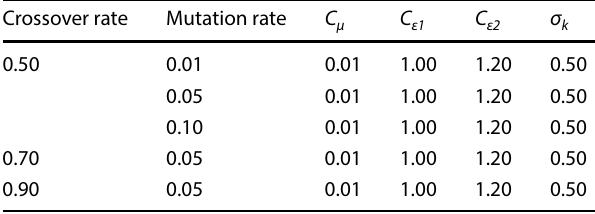
Table 5 Mean calibration values obtained from GA-based simu- lations for different crossover and mutation rates and p/k = 10, H = 1.2 mm narrow channel